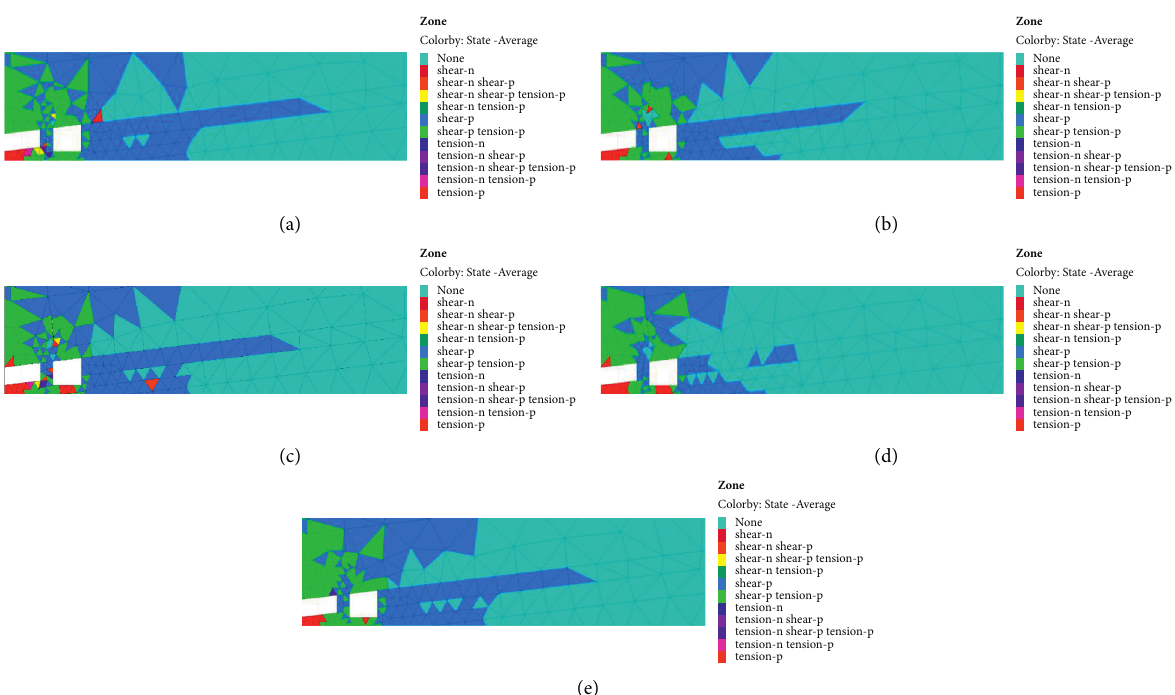
Figure 5: Distribution chart of surrounding rock plasticity under different cutting angles of prefabrication: (a) 0 ° ; (b) − 5 ° ; (c) 5 ° ; (d) 10 ° ; (e) 15 °